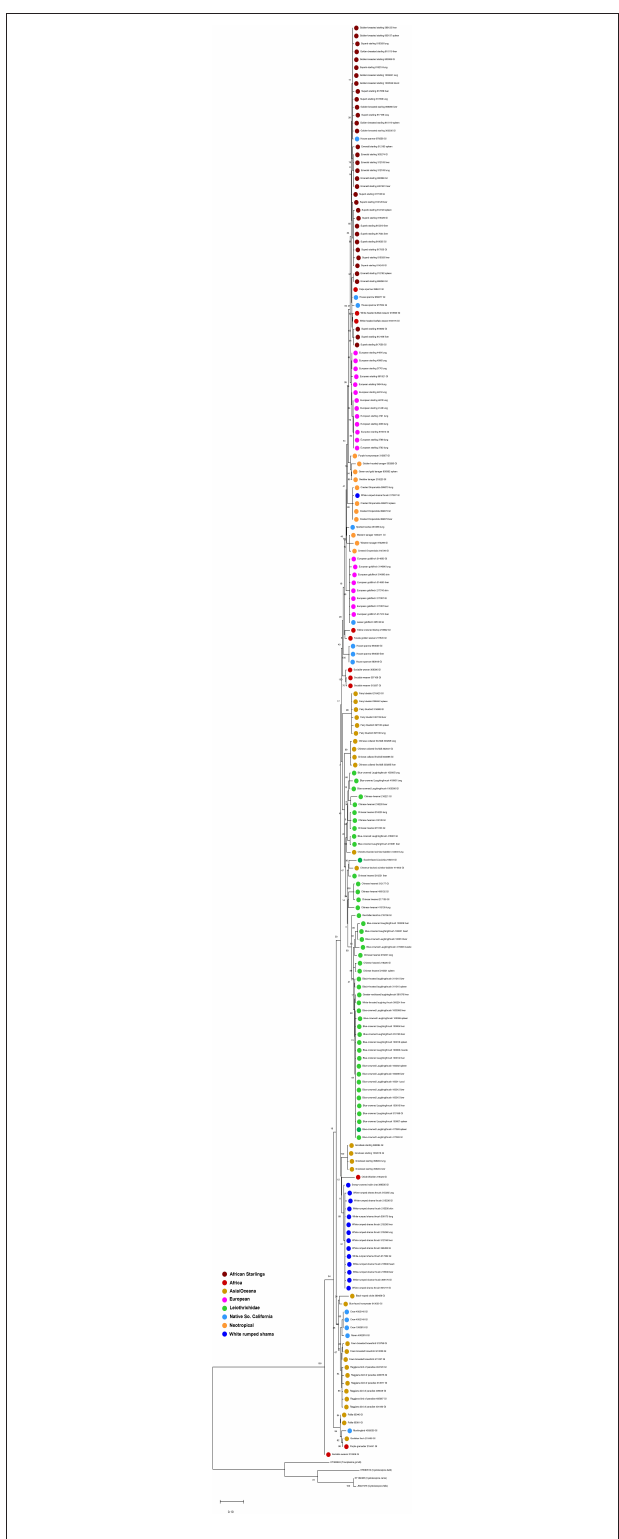
FIGURE 1 | Phylogenetic analysis of 181 partial amino acid sequences of the Isospora COI gene isolated from passerine birds. Sequences represent